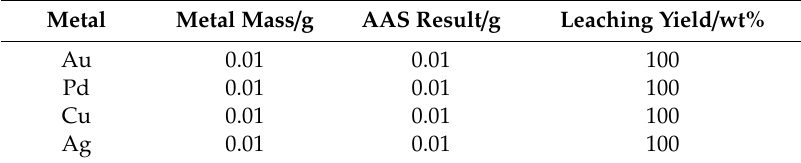
Figure 1. Metals dissolved by trichloroisocyanuric acid (TCCA)/N 4441 Cl (the dissolved metals are Pd, Cu, Au, Ag from left to right, respectively). Table 1. AAS (Atomic Absorption Spectroscopy) results of TCCA/N 4441 Cl to dissolve Au 0 , Pd 0 , Cu 0 , Ag 0 .